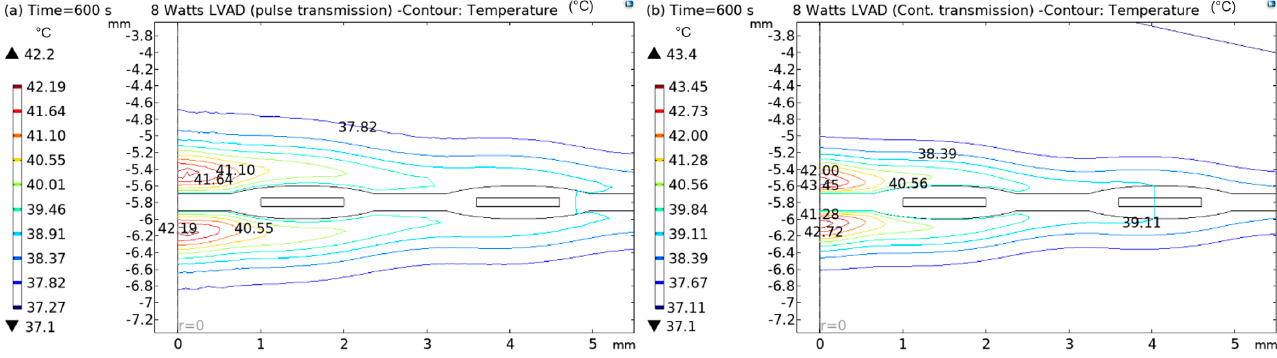
Figure 15. Contour plots of thermal analysis: ( a ) pulsed and ( b ) continuous transmission modes for 8 W LVAD.